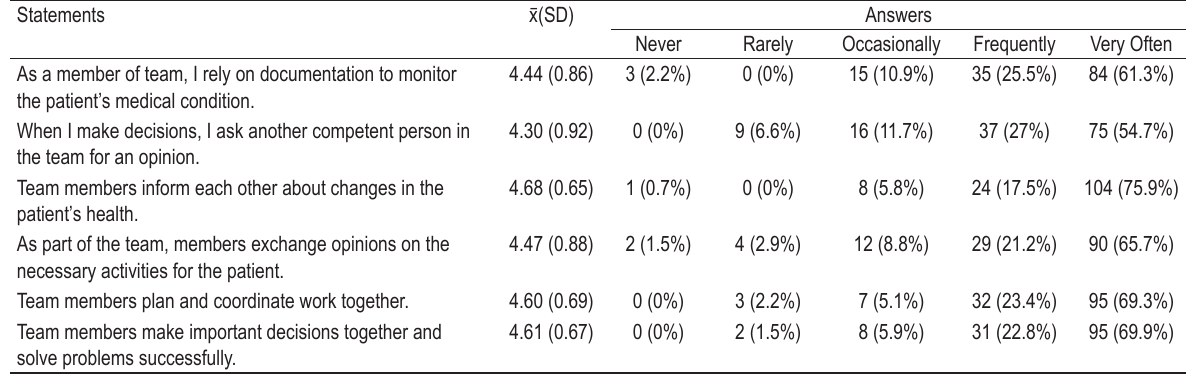
TABLE 4. Assessment of individual participation in an interprofessional team